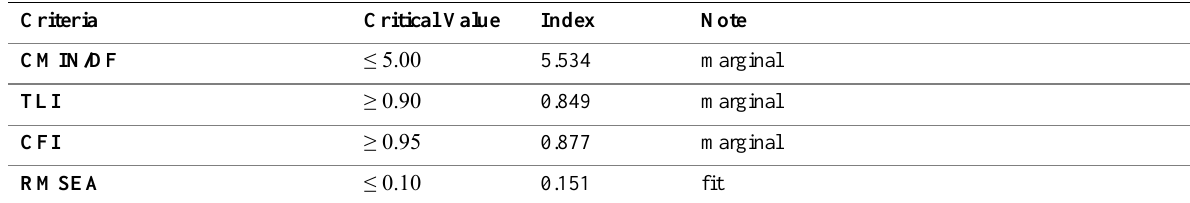
Table 2: The Results of Goodness of Fit